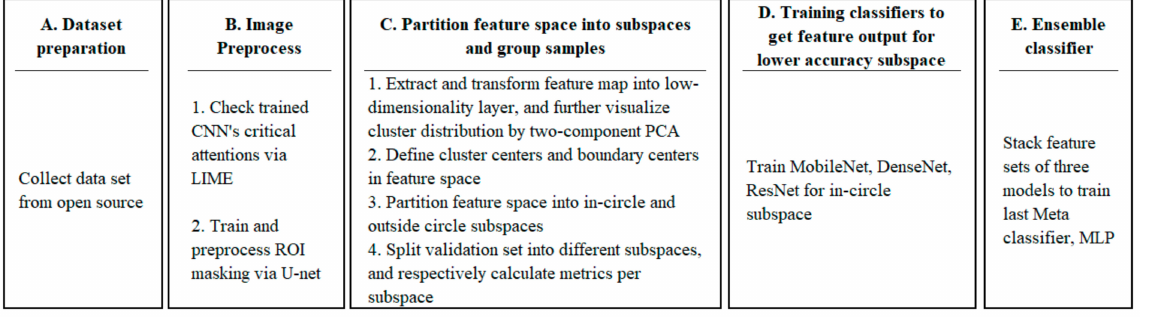
Figure 1. Training steps of this research.